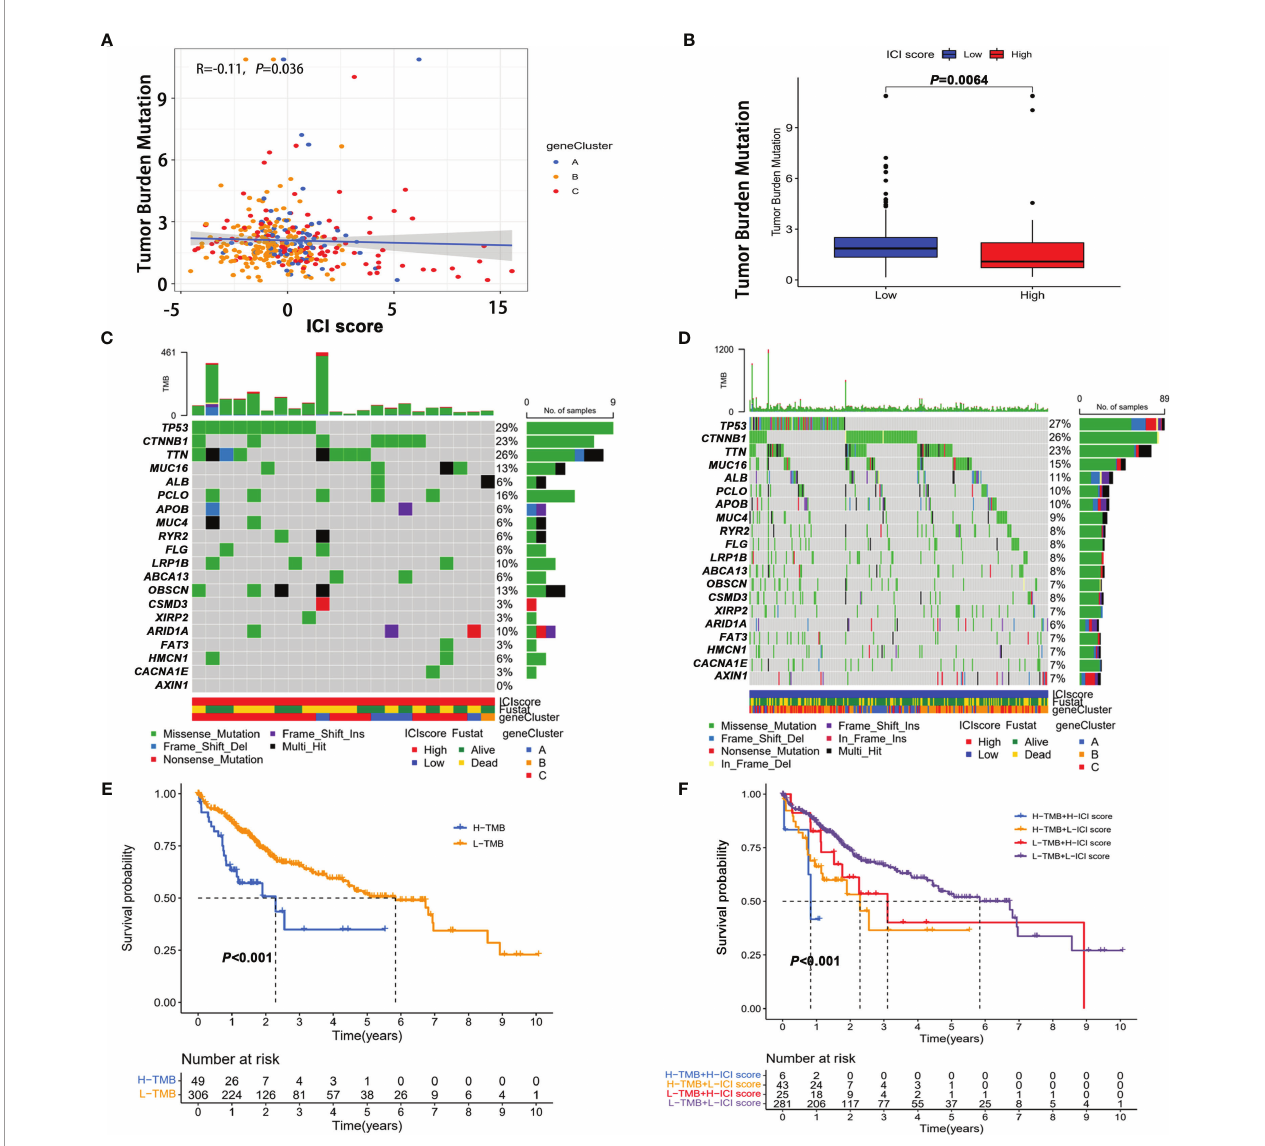
FIGURE 6 | The correlation between the ICI score and tumor mutation burden (TMB). (A) Correlation between tumor mutation burden and ICI score. (B) Comparison of TMB in high score and low score groups. The oncoPrint plots of tumor-related gene mutations in the high ICI score (C) and low ICI score groups (D) . (E) Kaplan – Meier curves of overall survival in the high TMB and low TMB groups. (F) Kaplan – Meier survival curve for high/low TMB combined with high/low ICI